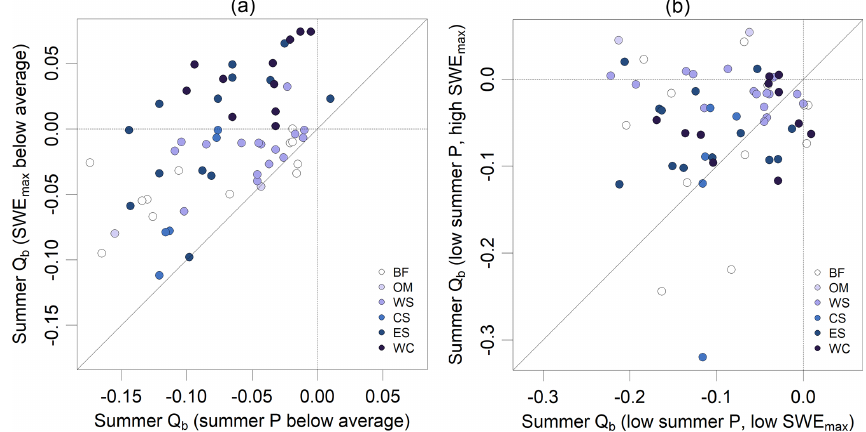
Figure 7. (a) Relation of median summer baseflow for years with below-average summer precipitation and years with below-average SWE max . (b) Median summer baseflow for years with both below-average summer precipitation and below-average SWE max related to median summer baseflow for years with both below-average summer precipitation and above-average SWE max . Points represent individual catchments; colour represents region of the specific catchment (see Sect. 2.1 for region